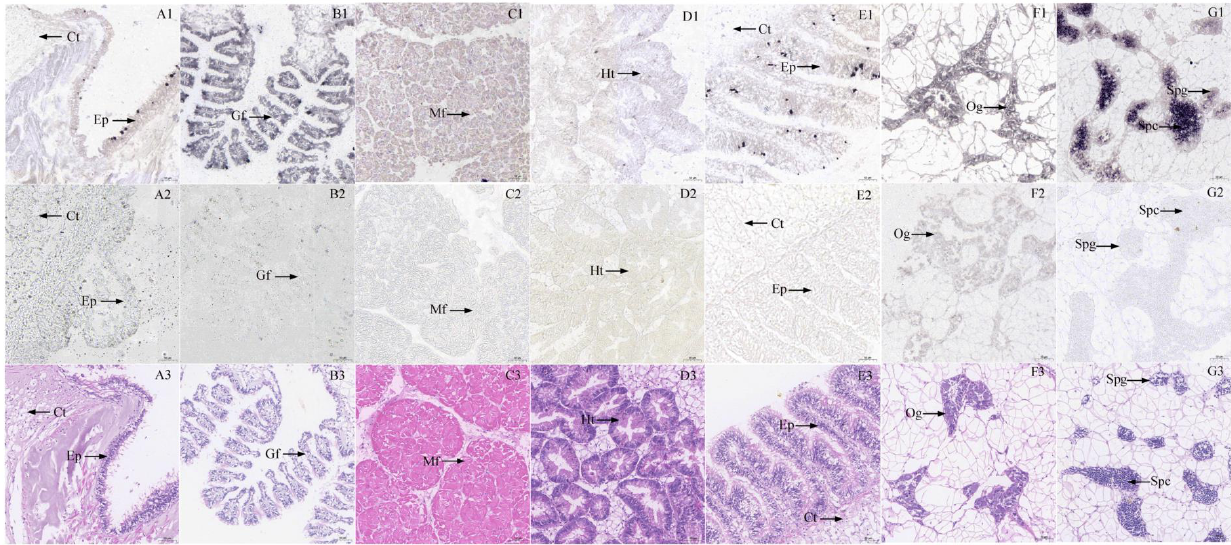
Figure 3. The distribution of GS K3β in the mantle ( A1 – A3 ), gill ( B1 – B3 ), adductor muscle ( C1 – C3 ), hepatopancreas ( D1 – D3 ), labial palp ( E1 – E3 ), ovary ( F1 – F3 ), and testis ( G1 – G3 ) of C. ariakensis at the proliferative stages. A1, B1, C3, D1, E1: GSK3β antisense probe; A2, B2, C2, D2, E2: sense probe; A3, B3, C3, D3, E3: hematoxylin – eosin staining. Ct: conjunctive tissues; Ep: epithelium; Gf: gill filament; Mf: muscle fiber; Ht: hepatic tubule; Og: oogonia; Spg: spermatogonia; Spc: spermatocyte.